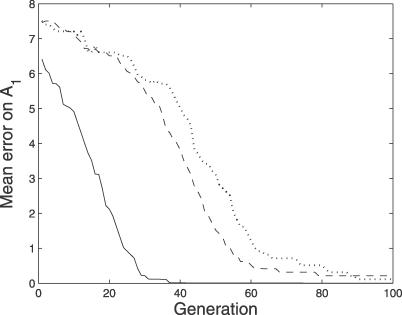
Effect of Free-Lunch Learning on Performance ErrorThe graph shows the mean results of ten computer simulation runs, in three conditions: FLL, NoFLL, and NoLearn (see text). In each run, the fitness of each of 1,000 networks was determined by performance error on a fixed set A = A
1 ∪ A
2 of 20 associations; a different set A was used for each run. For all graphs in this paper, the median (of error, here) of 1,000 networks was obtained throughout each run, and the mean of ten medians is shown for each generation in each condition (standard errors were no greater than 0.5, and are not shown for clarity).
Condition FLL (solid line): mean performance error Epost(A
1) on the ten associations in A
1 after learning the ten associations in subset A
2. Learning A
2 had a beneficial effect on performance on A
1 over 100 generations, corresponding to an increase in the amount and prevalence of FLL (see Figure 6). Condition NoFLL (dashed line): mean performance error Epost(A
1) was evaluated as in condition FLL, except that the input vectors in A
1 were orthogonal to those in A
2, so that learning A
2 could not have any effect on performance on A
1 (see text). Condition NoLearn (dotted line): mean performance error Epre on A
1 was evaluated “at birth” (i.e., no within-lifetime learning was allowed).